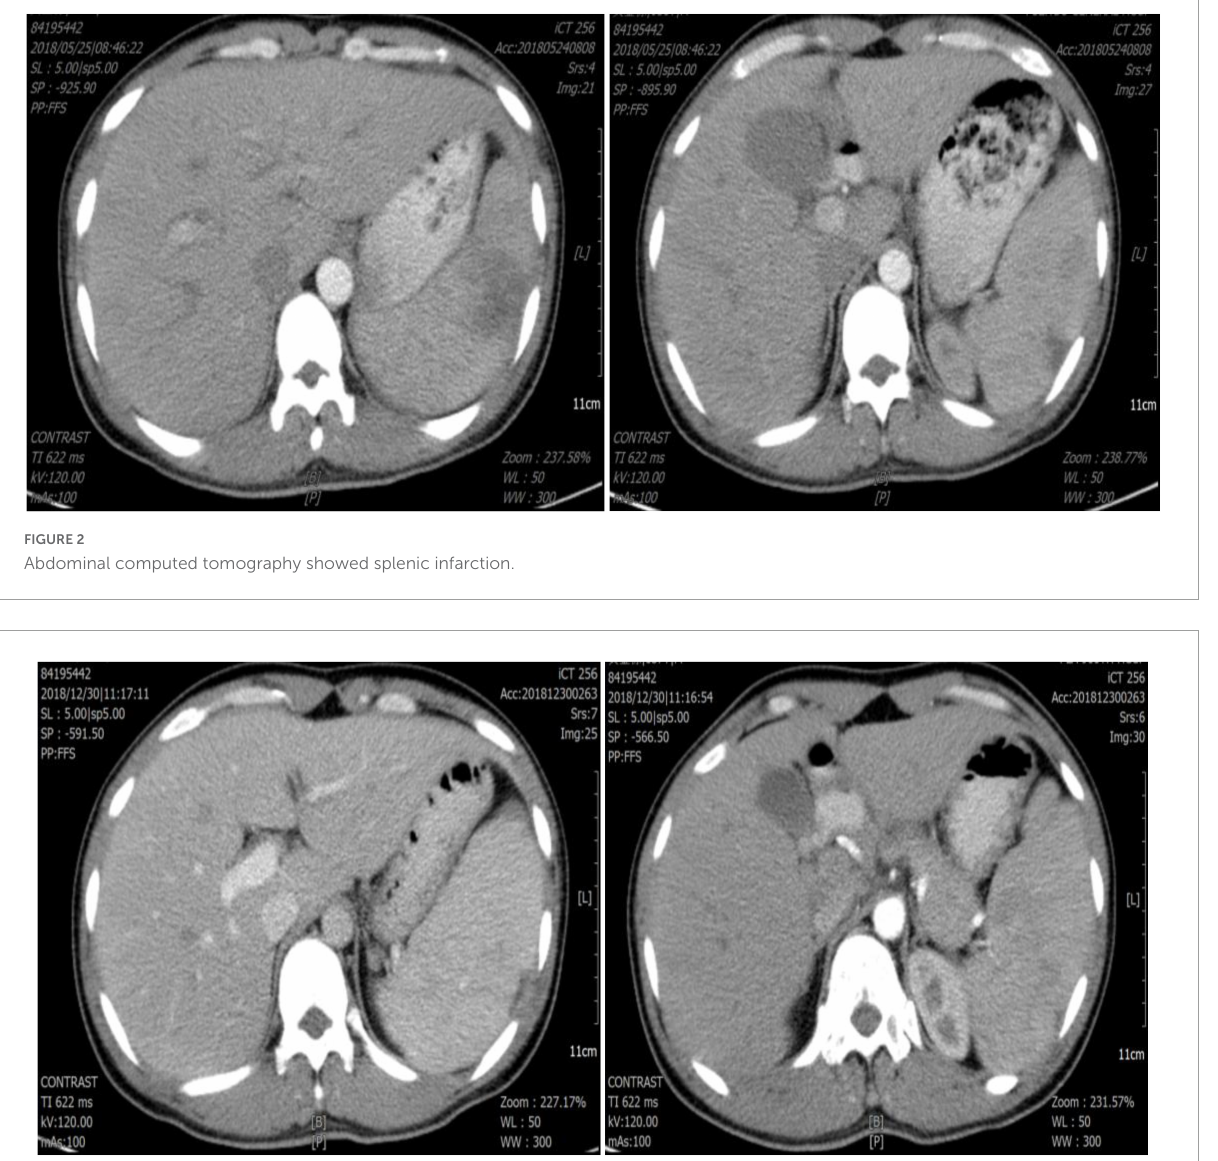
FIGURE3 Abdominal computed tomography showed relief of splenic